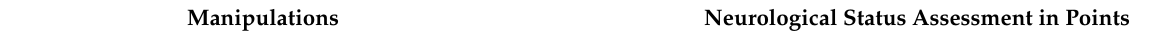
Table 1. Neurological deficit in the animals after assessment, using the McGrow stroke-index scale with A. E. Kulchikov’s modification [36]. Manipulations Neurological Status Assessment in Points Normally, the animal puts both paws on the table, if the animal The animal was brought to the table, the back of the front legs does not place the paralyzed limb on the table—1 point; does should touch the edge of the table. not put both limbs—2 points. The animal was fixed by the tail above the table and gradually Normally, the animal tries to grab the edge of the table with its lowered so that the vibrissa touched the table. front paws, if there is no reaction, 2 points are assigned. The animal was fixed by the tail above the table and gradually Normally, the animal tries to grab onto the edge of the table lowered so that the vibrissa did not touch the edge of the table. with its front paws, if there is no reaction, 2 points are assigned.